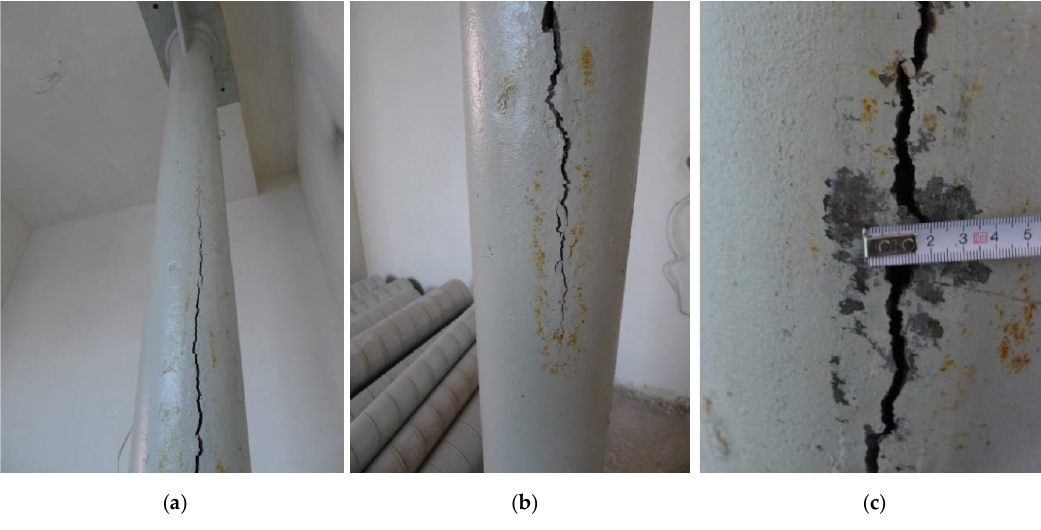
Figure 16. View of the damaged cast-iron columns (visible cracks of a width of few millimeters): ( a ) room no. 1, ( b ) room no. 2, ( c ) detail of the crack.